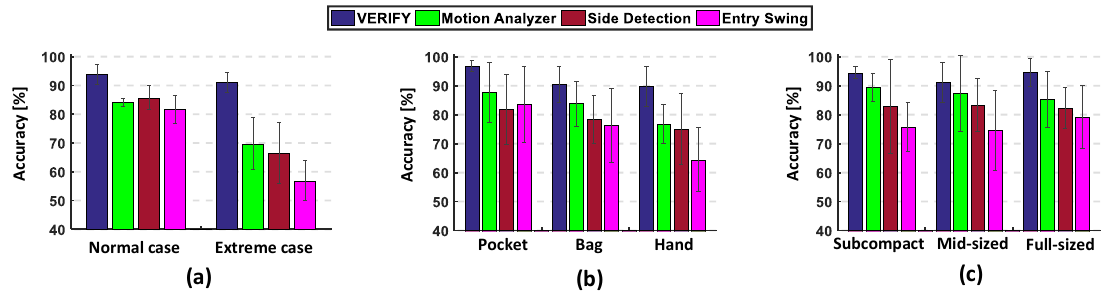
Figure 6. Experimental results on accuracy: ( a ) for normal and extreme cases; ( b ) by varying the position of smartphone on the body; ( c ) for three vehicle